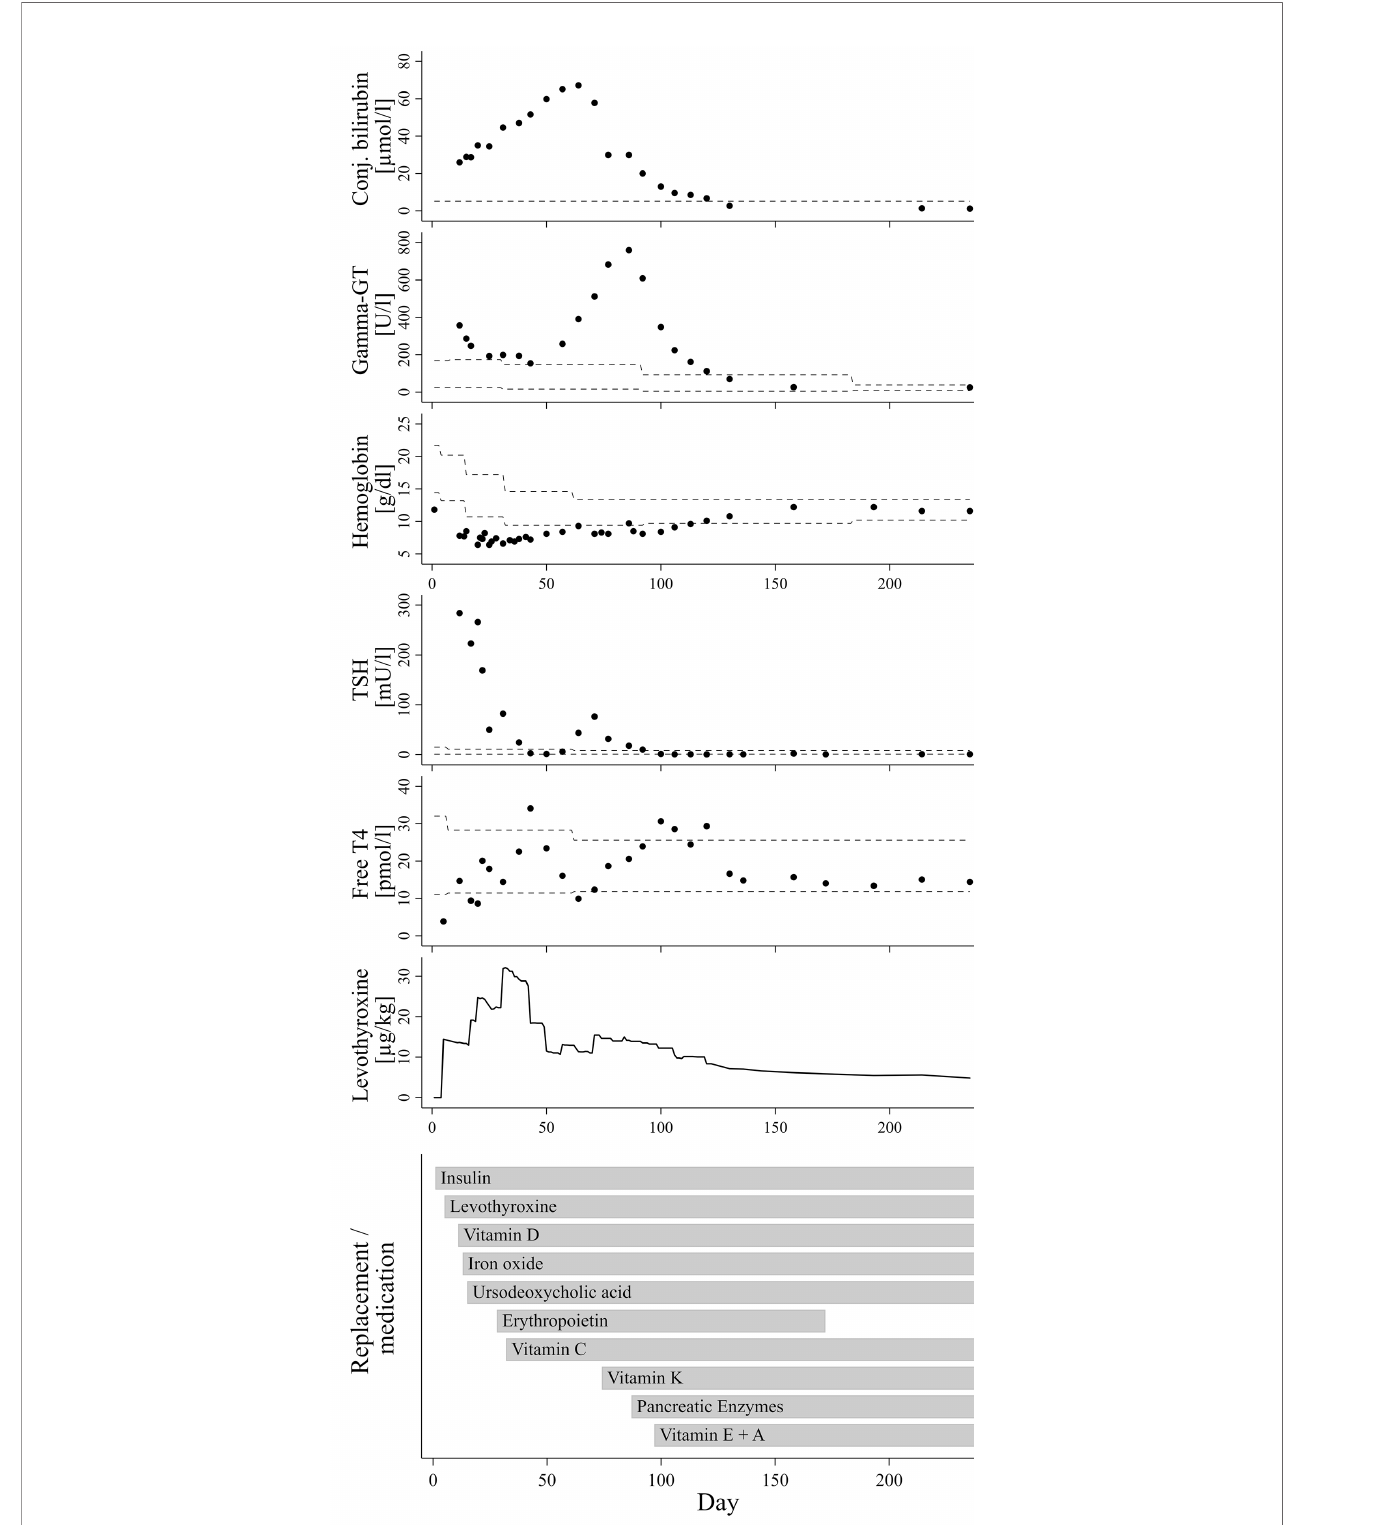
FIGURE 1 | Course of laboratory parameters and treatment over time. The dashed lines indicate age-adjusted reference values.